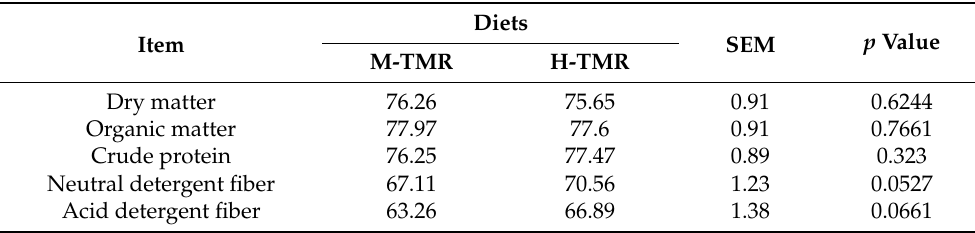
Table 5. In vivo digestibility coefficients (LSM) of buffaloes fed total mixed ration based on maize silage (M-TMR) and hay